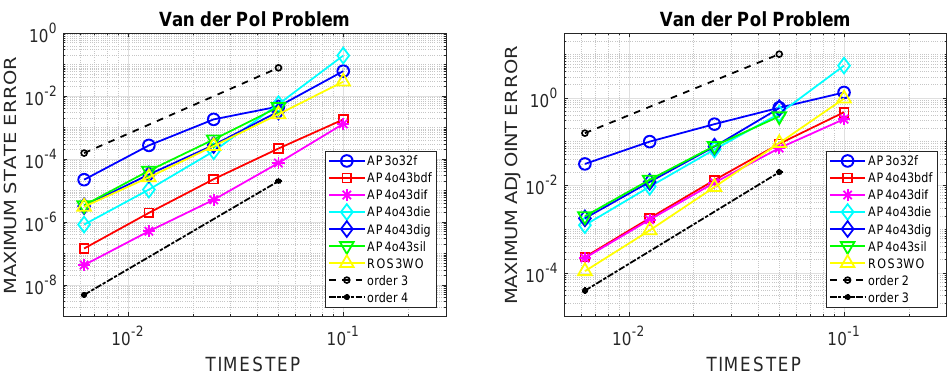
Figure 2. Van der Pol Problem: Convergence of the maximal state errors (cid:107) ( w T ⊗ I ) Y n − y ( t n + 1 ) (cid:107) ∞ ( left ) and adjoint errors (cid:107) ( v T ⊗ I ) P n − p ( t n ) (cid:107) ∞ ( right ), n = 0, . . . , N